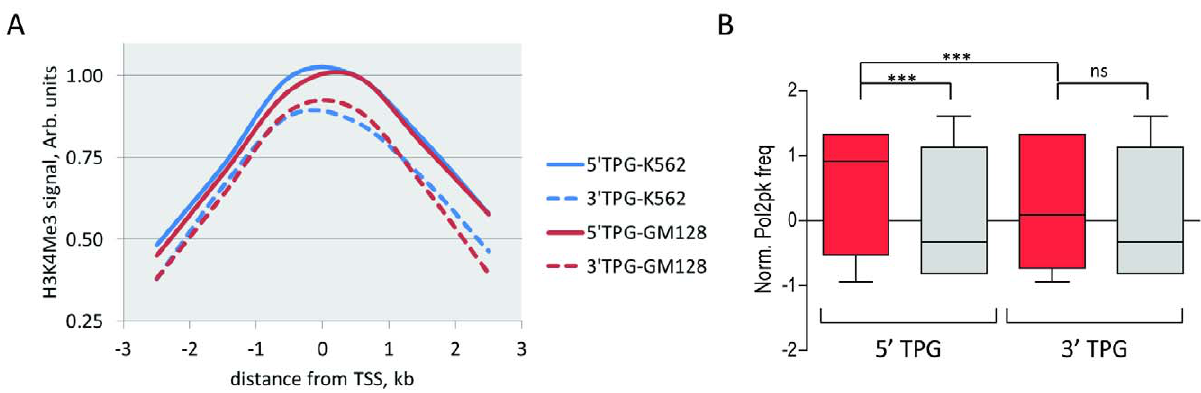
Figure 2. Characteristics of promoters of 5 9 and 3 9 TPGs. A : Averaged histone H3K4 trimethylation mark around promoters of TPGs for K562 and GM128 cell lines (log2 values of signal, normalized to max. value). B: Normalized Pol2 peak frequency for 5 9 and 3 9 TPGs in cell lines of hematopoietic (red bars) and non-hematopoietic (grey bars) origin. ***, ns: P , 0.001, non-significant; Wilcoxon signed rank test.